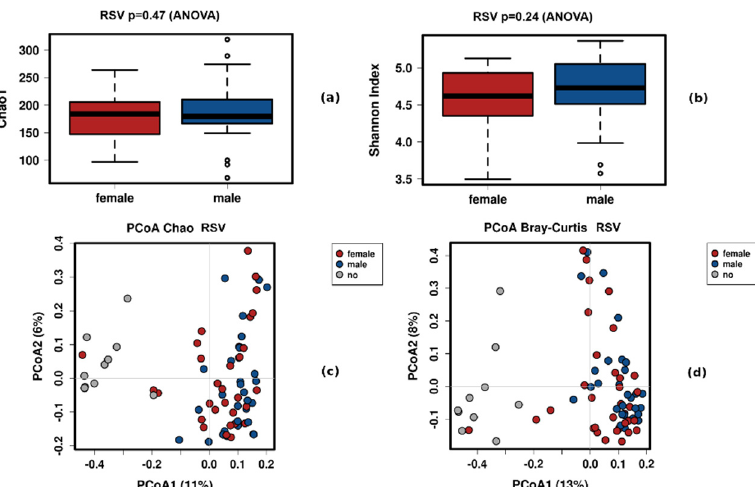
Figure 4. Alpha and beta diversity comparing female (red) and male (blue) participants. Alpha diversity boxplots were created for ( a ) Chao1 and ( b ) Shannon indices of female and male participants. There are no significant changes in Alpha diversity between the sexes. The black lines indicate average diversity. Samples were rarefied to 6600 reads, so plots were comparable with others in this study. PCoA plots were created for ( c ) Chao and ( d ) Bray–Curtis of the female and male participants. There is no significant grouping between the sexes, but the controls and the product control (“no”–grey) are grouped separately.